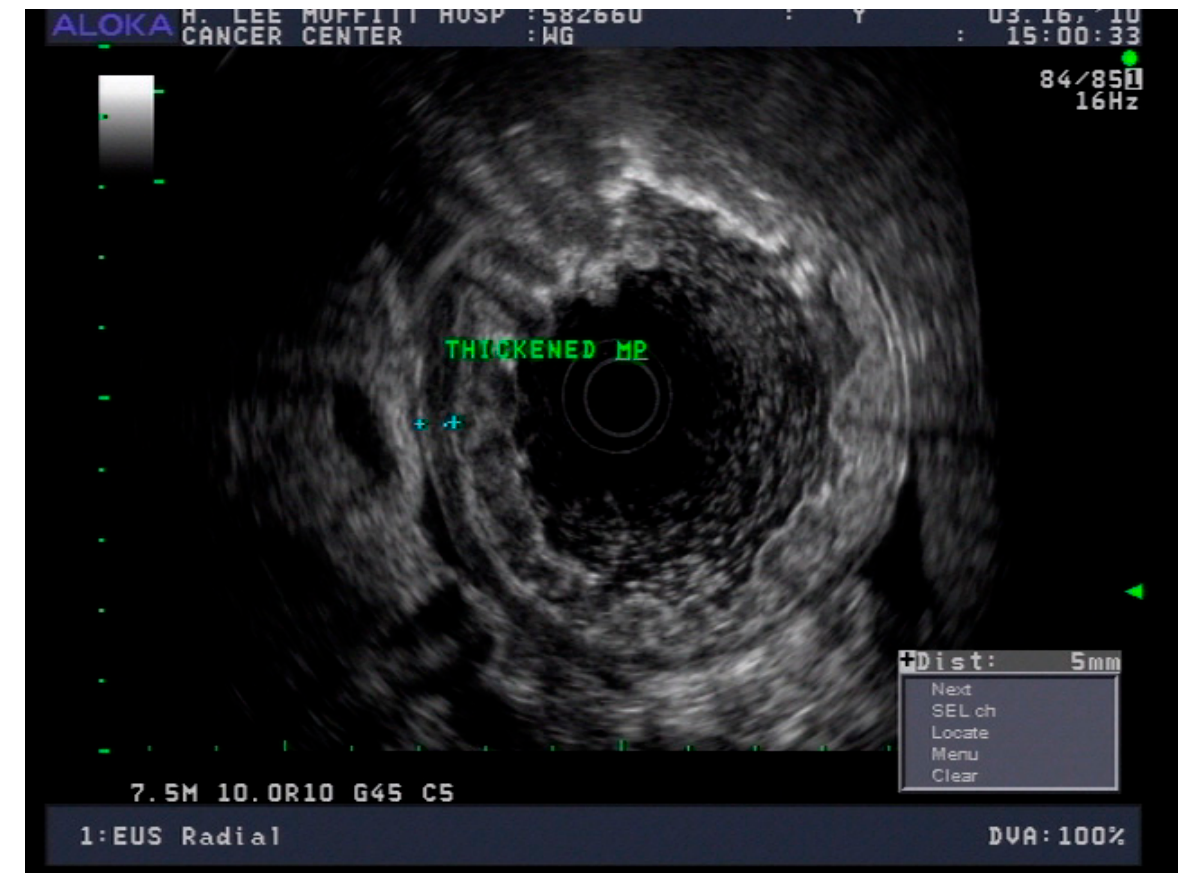
Figure 15. EUS Linitis plastica with significant wall thickening.